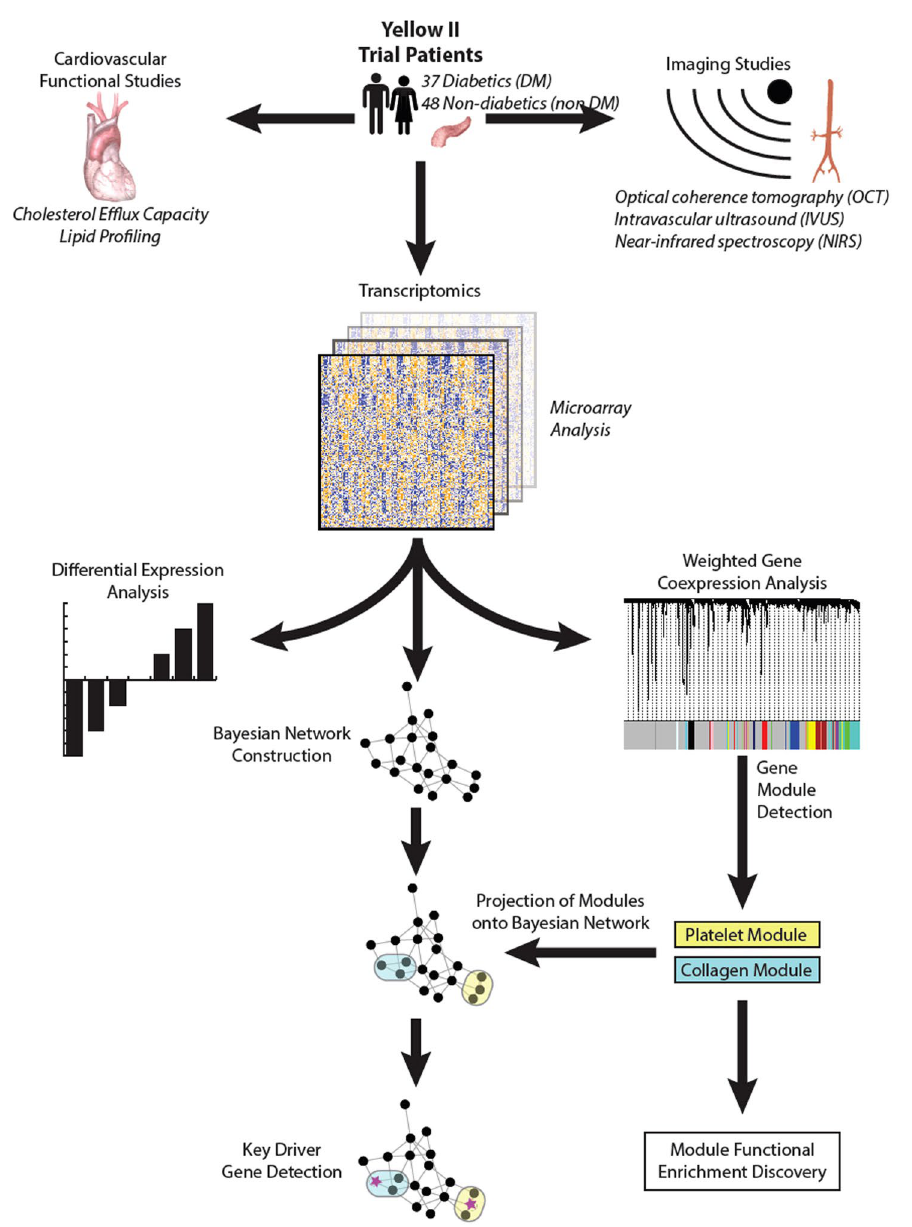
Figure 1. Schematic of transcriptomic analysis